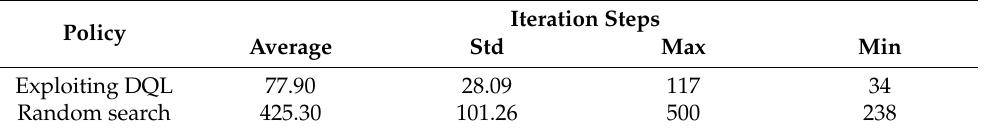
Table 2. Comparison of iteration steps to convergence between DQL and random search. Iteration Steps Policy Average Std Max Min Exploiting DQL 77.90 28.09 117 34 Random search 425.30 101.26 500 238